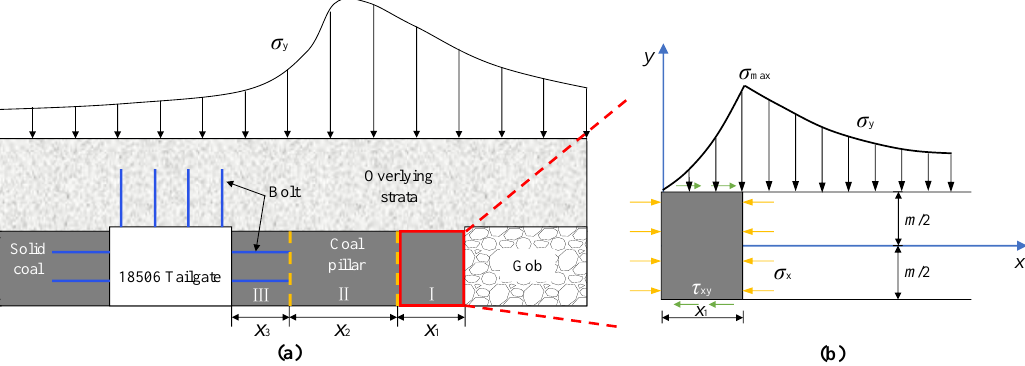
Figure 2. Mechanical model of coal pillar in roadway protection: ( a ) mechanical model of roadway pillar; ( b ) plastic fracture zone.